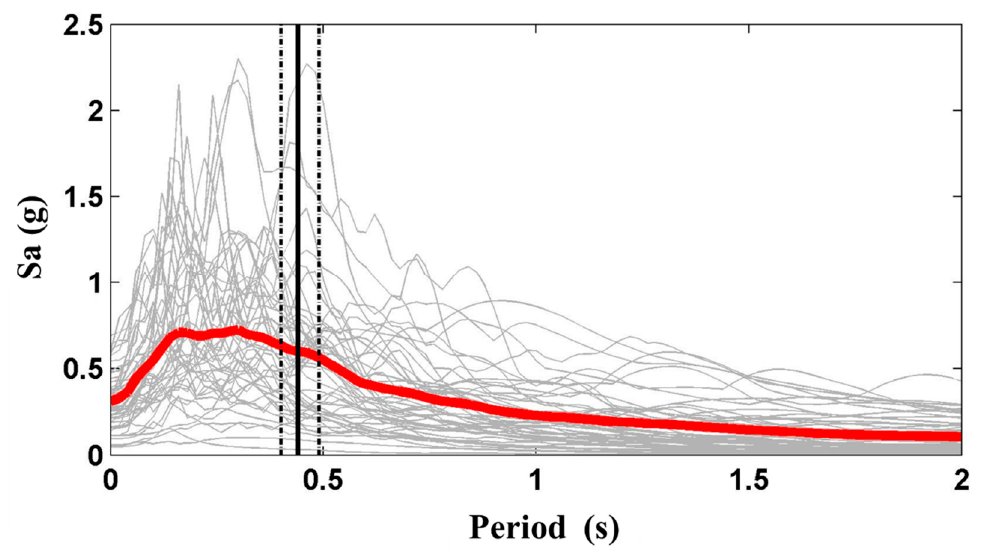
Figure 6. Response spectrum of selected ground motion records.